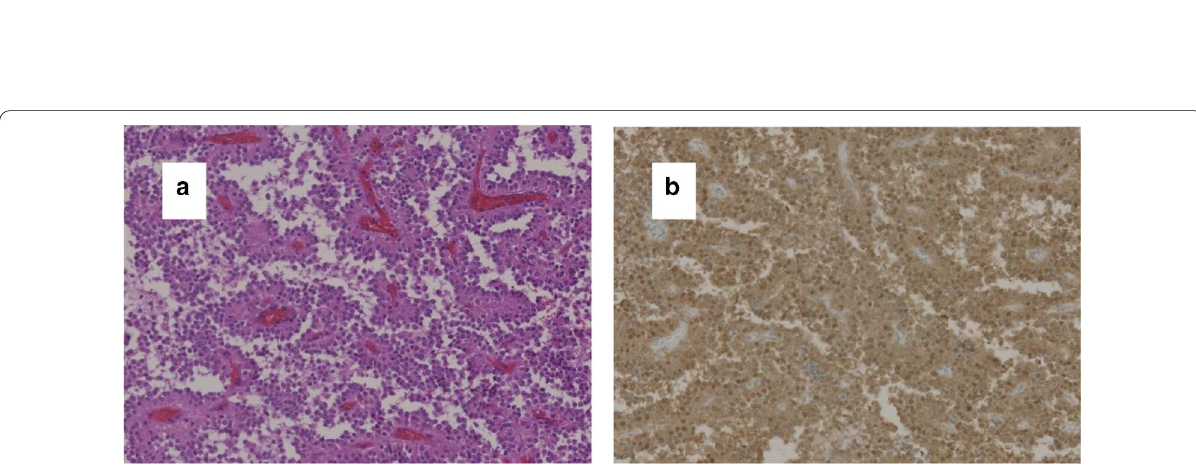
Fig. 5 Pathological findings of the pancreatic tumor (a; hematoxylin & eosin cytoplasm positive for β-catenin (b; ×